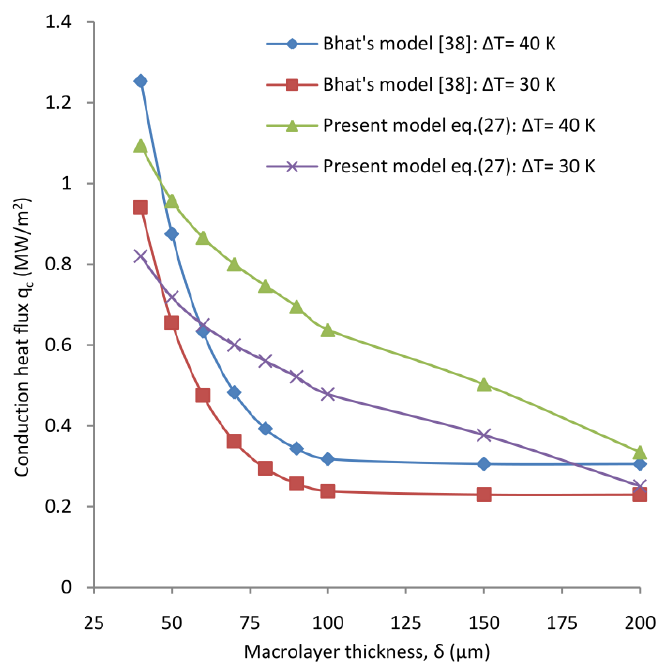
Figure 14. Relative dependence of the conduction heat fluxes on the macrolayer thickness at di ff erent superheats (t = 15 ms).